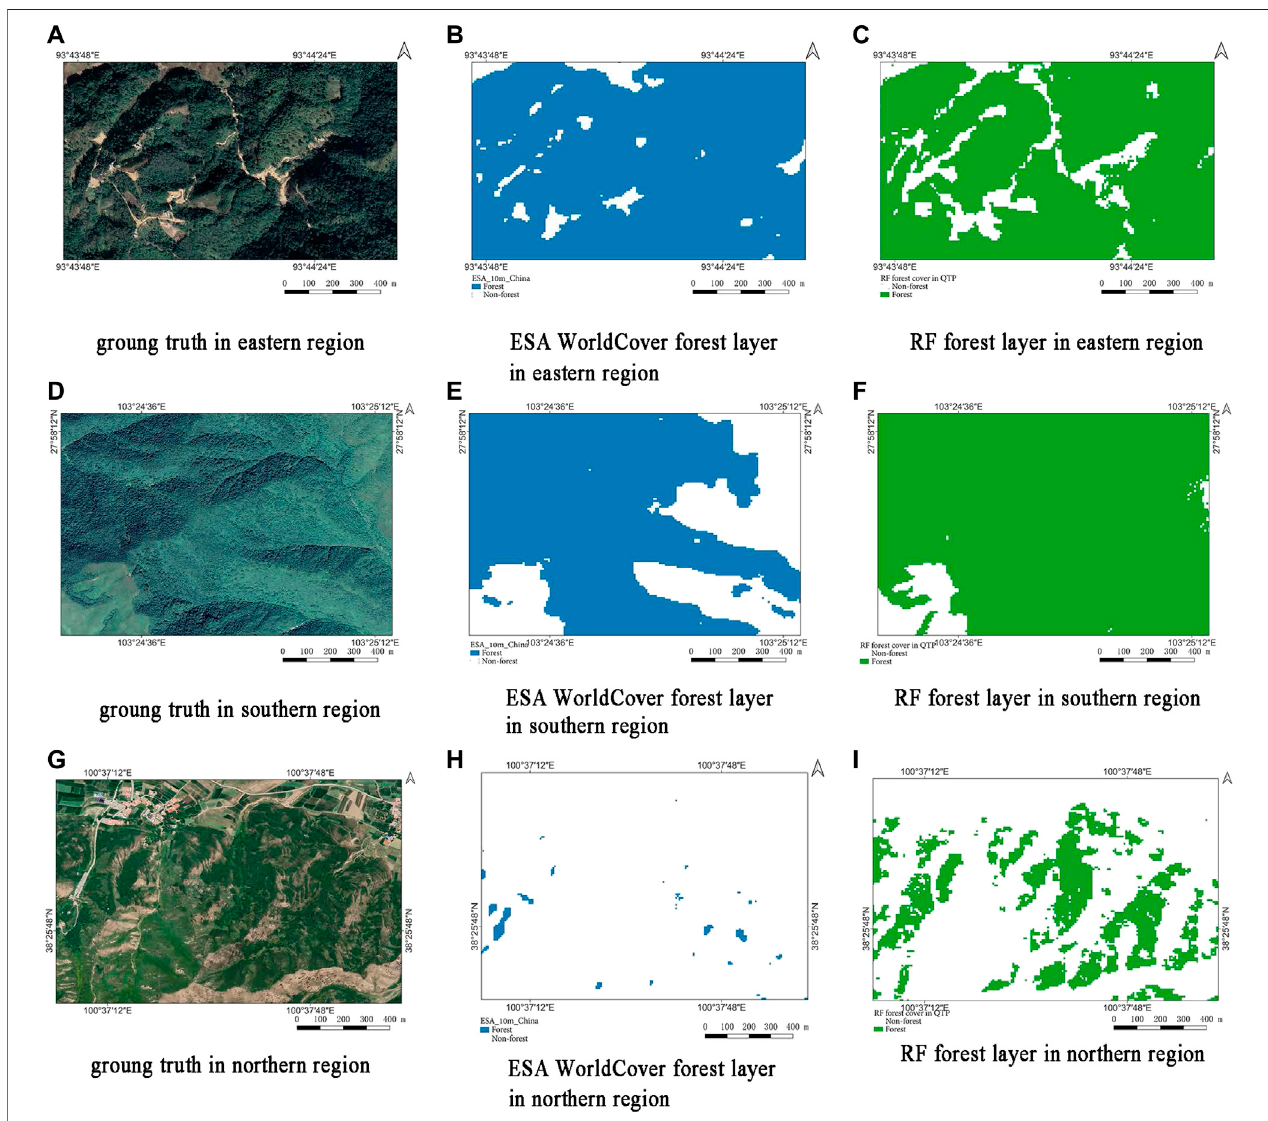
FIGURE 11 | Comparison of the ground truth (Google Earth), (B,E,H) ESA WorldCover forest layer, and RF forest layer in the eastern (A,C) , southern (D,F) , and northern (G,I) regions of the QTP.